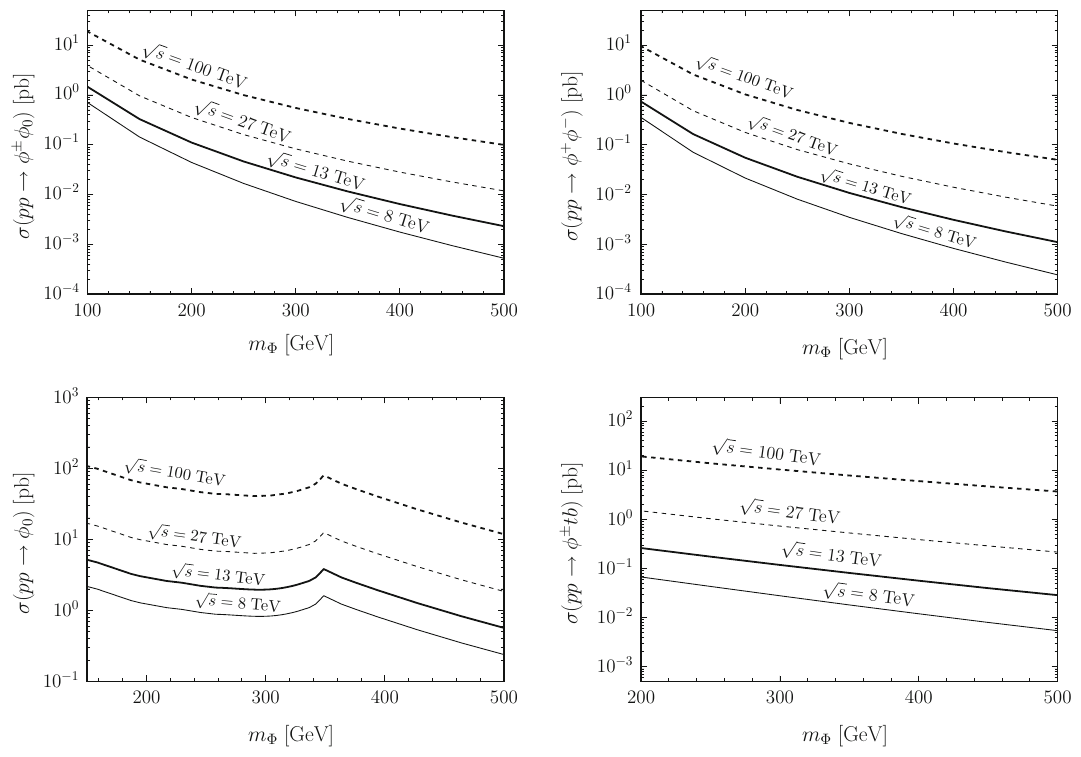
Fig. 8 Cross section of the different production modes for (cid:2) at pp colliders of different c.m.e. The coupling c / f is set to 1TeV − 1 . The production cross section of φ 0 via gluon fusion was rescaled from Ref. √ s = 13 TeV. To obtain the cross sections for other c.m.e., [63], at